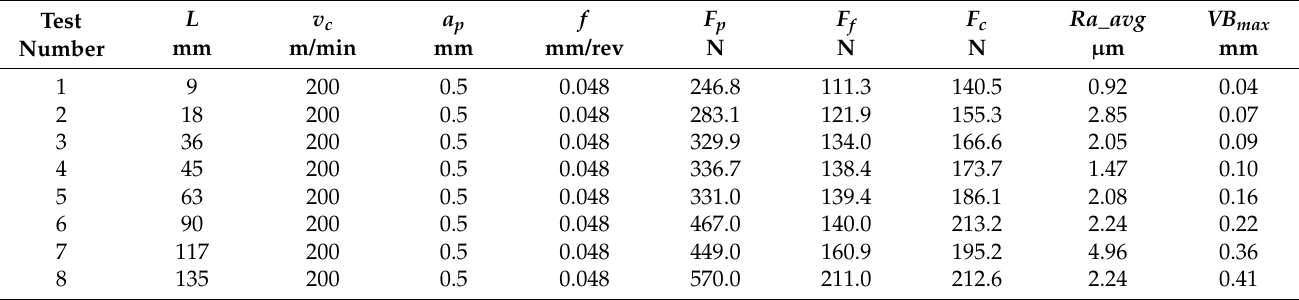
Table 7. Summary of the results of measurements of the cutting edge wear, the values of the components of the total cutting force, and the Ra arithmetic mean value of surface roughness for the case of turning with a speed v c = 200